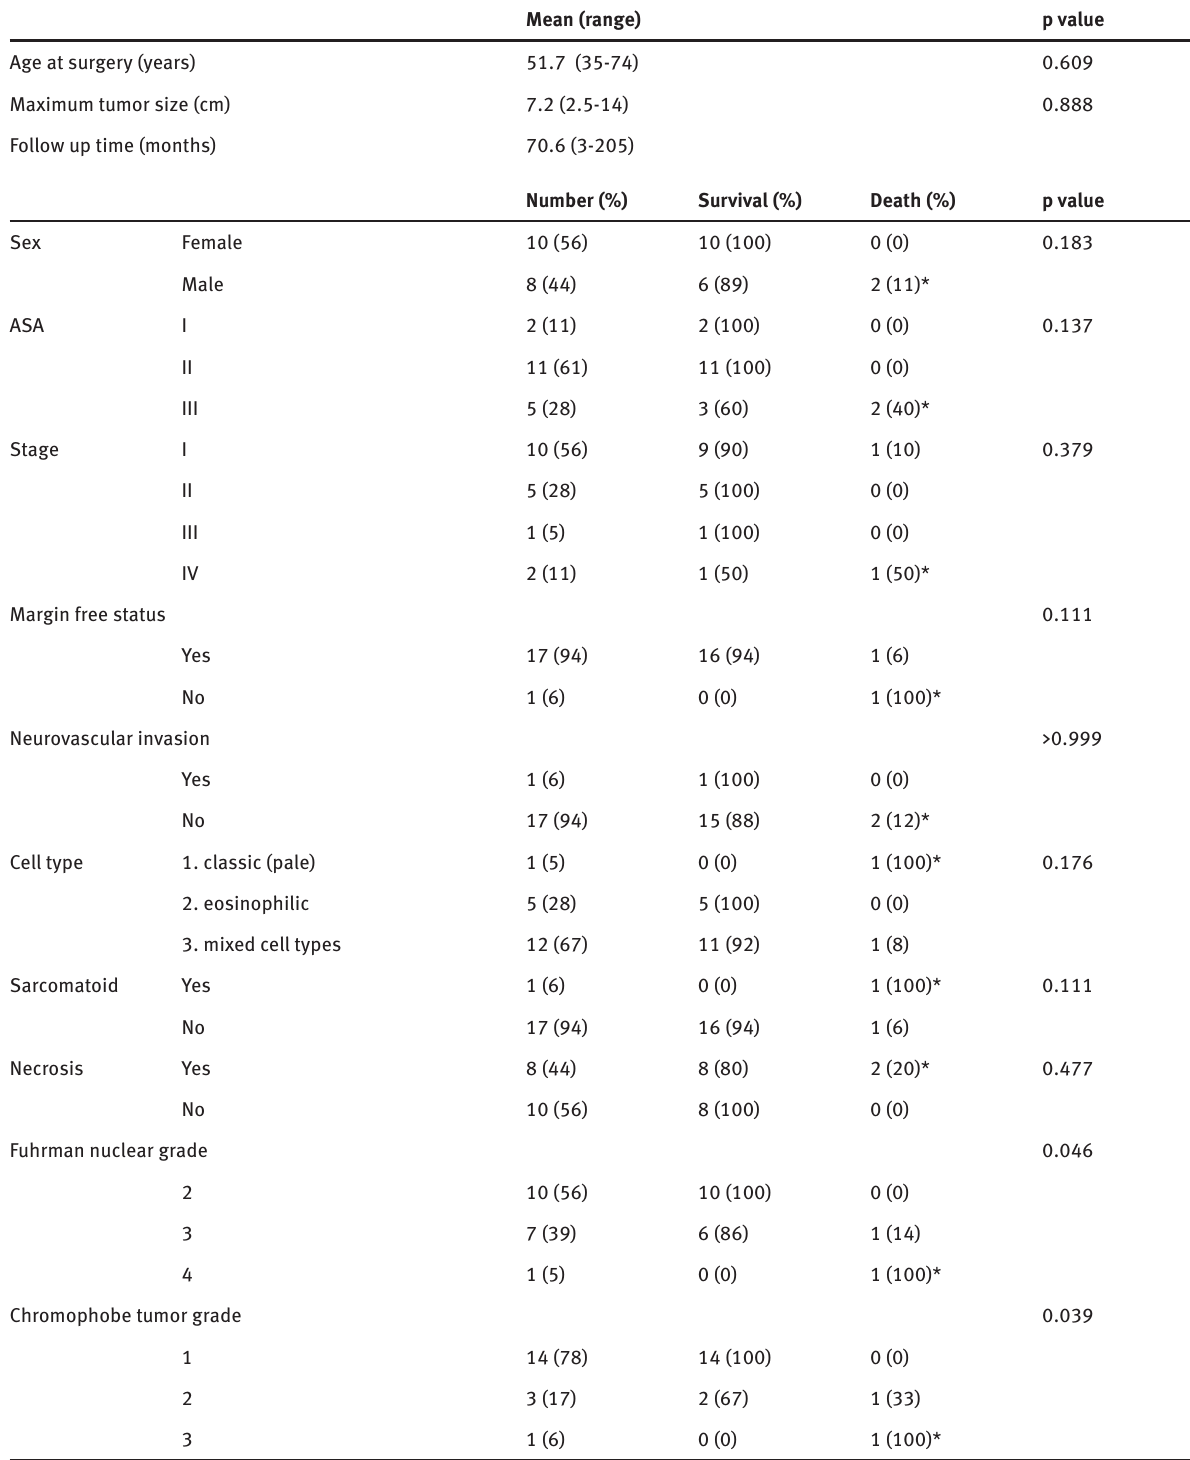
Table 2: Clinicopathologic and demographic characteristics of patients. Associations between survival and